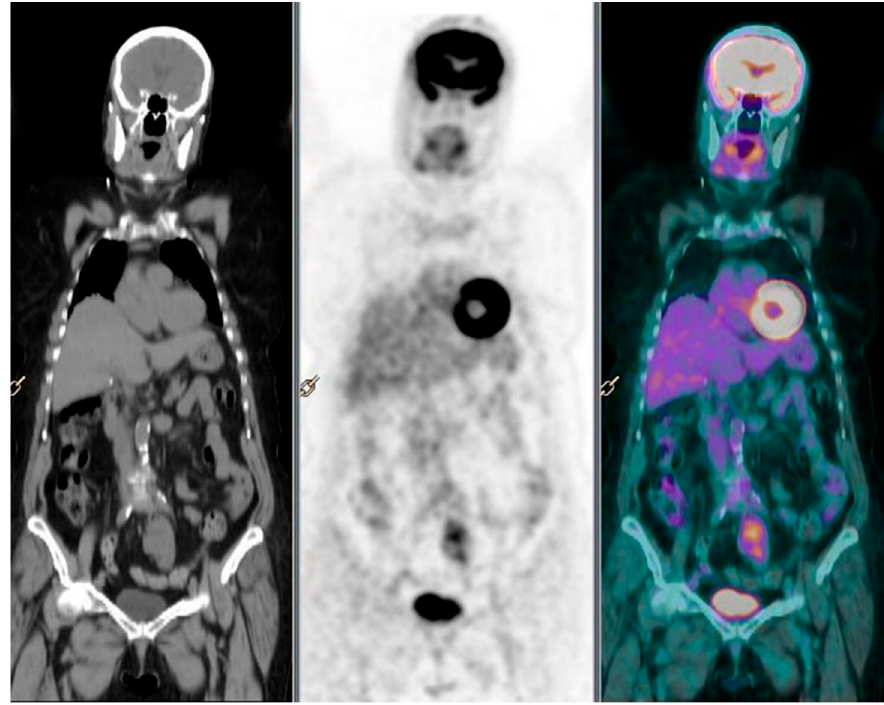
Figure 5. PET/CT scans performed at October 2020: The examination does not show pathologies with a high glucose metabolism.